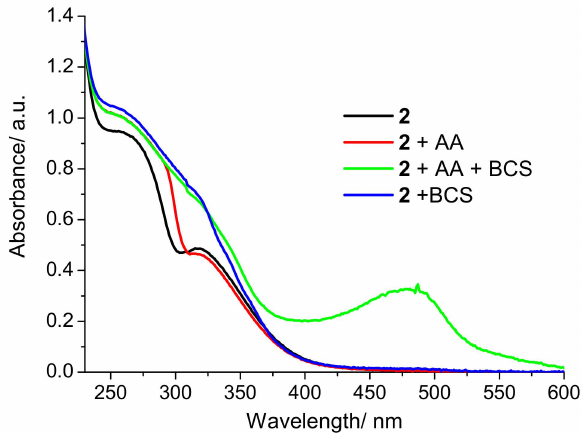
Figure 2. UV-Vis spectrum of 2 (50 µ M) in PBS:DMSO (200:1) (black line), 2 (50 µ M) in the presence of ascorbic acid (500 µ M) in PBS:DMSO (200:1) (red line), 2 (50 µ M) in the presence of ascorbic acid (500 µ M) and bathocuproine disulfonate, BCS (100 µ M) in PBS:DMSO (200:1) (green line), 2 (50 µ M) in the presence of bathocuproine disulfonate, BCS (100 µ M) in PBS:DMSO (200:1) (blue line), all at 37 ◦ C.